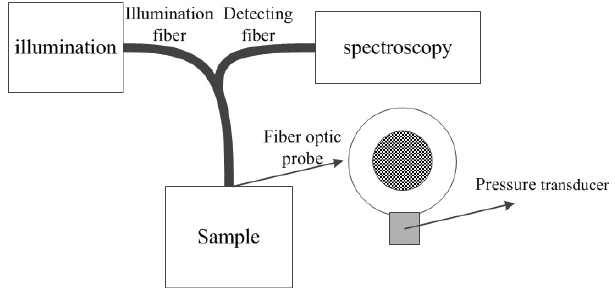
Fig. 3. Schematic of the measurement system and ¯ber optic